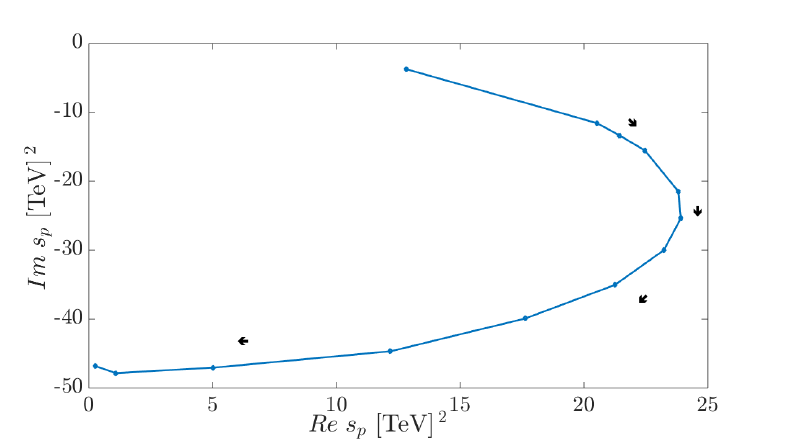
Figure 12: Motion of a resonance pole in the complex plane, for ∈ [ − 3.56, − 1.5 ] · 10 − 4 , a = − 1.75 · 10 − 4 and a = b 1 / 2 = 0.9 for the basic a 4 5 IAM. The arrows indicate the flow of the pole position with increasing absolute value for a 4